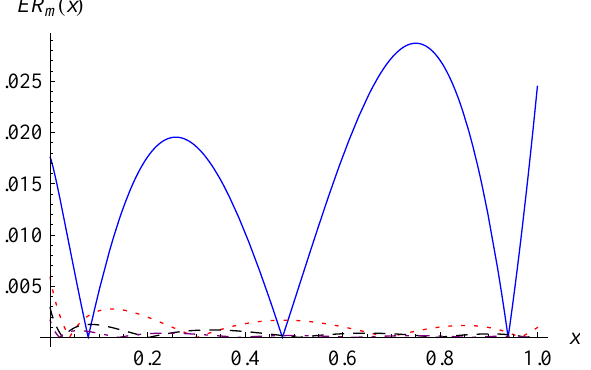
Figure 1. The error functions ER m ( x ) for m = 2 (solid line), m = 3 (dot line), m = 4 (dash line) and m = 5 (dot-dash